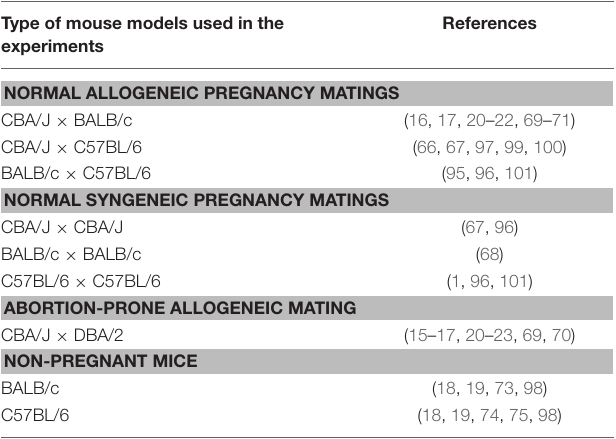
TABLE 1 | Type of mouse models used in the